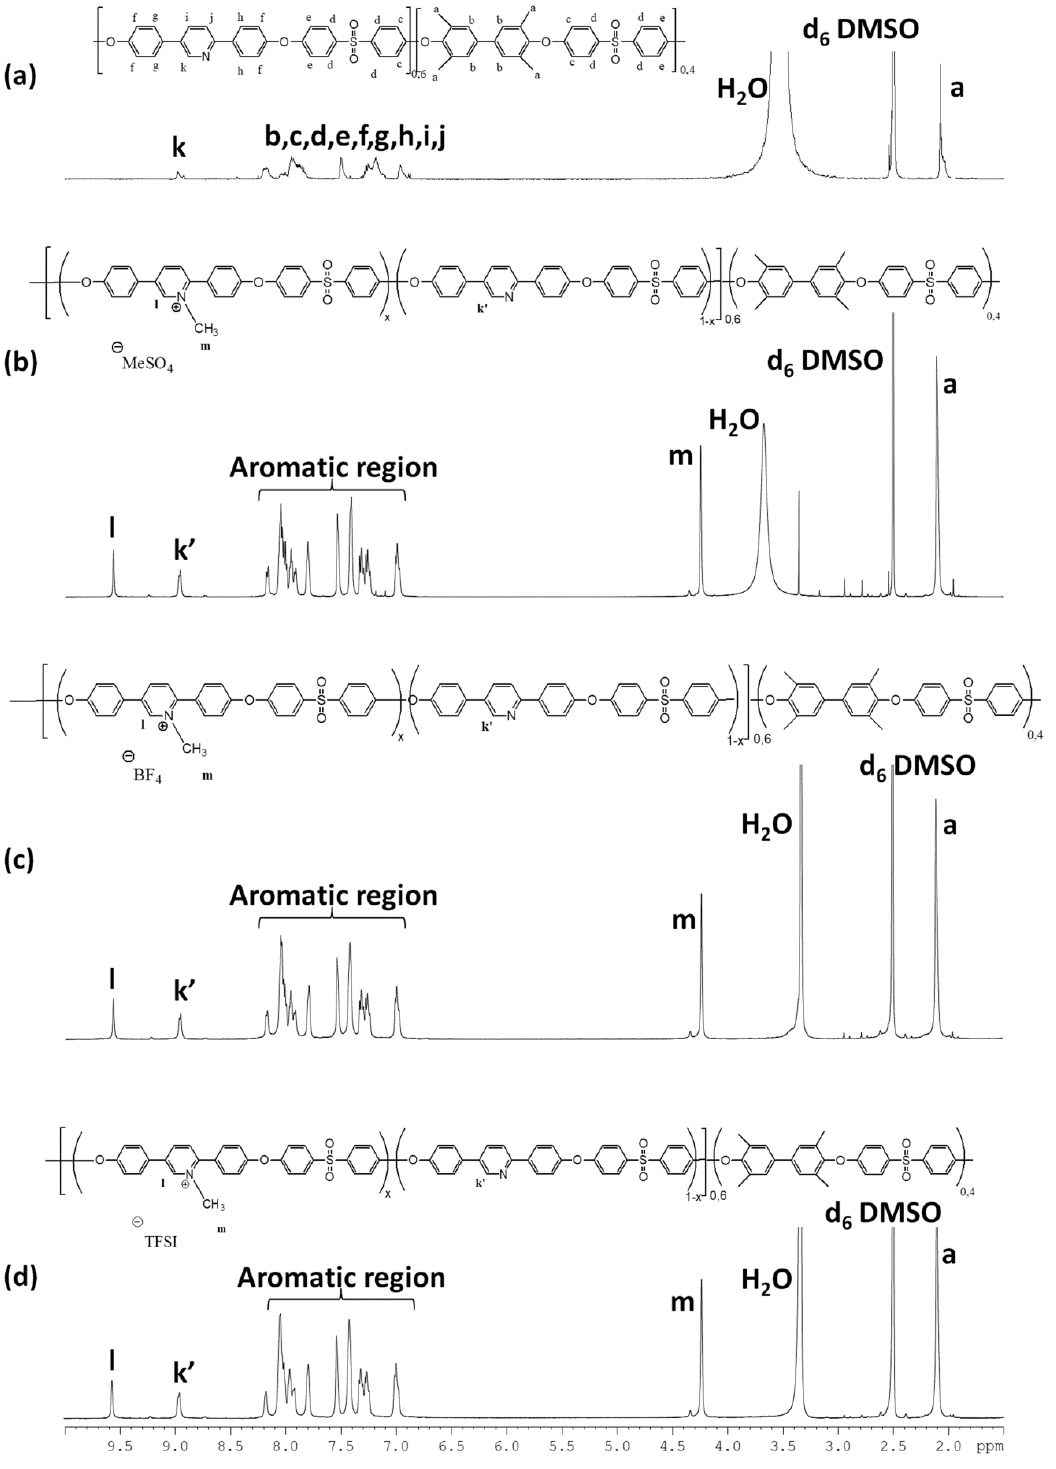
Figure 1. 1 H NMR spectra (DMSO- d 6 ) of precursor polymer Py-APE ( a ) and its corresponding PIL Figure with counter anions ( b ) MeSO 4− , ( c ) BF 4− and ( d ) TFSI − .